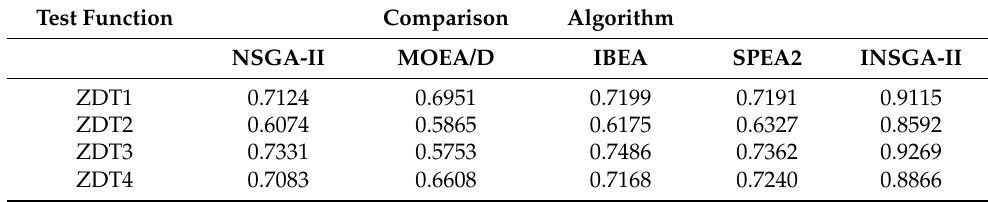
Table 3. HV metric results for DTLZ function.